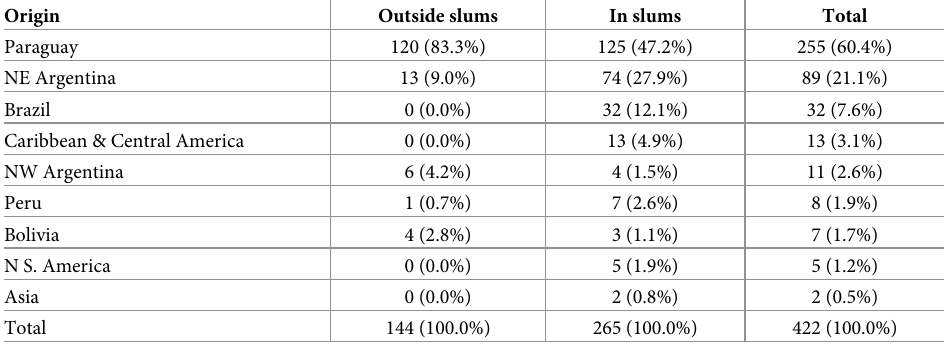
Table 1. Number of imported dengue cases in Buenos Aires according to likely origin of infection and residential address located in or outside slums.